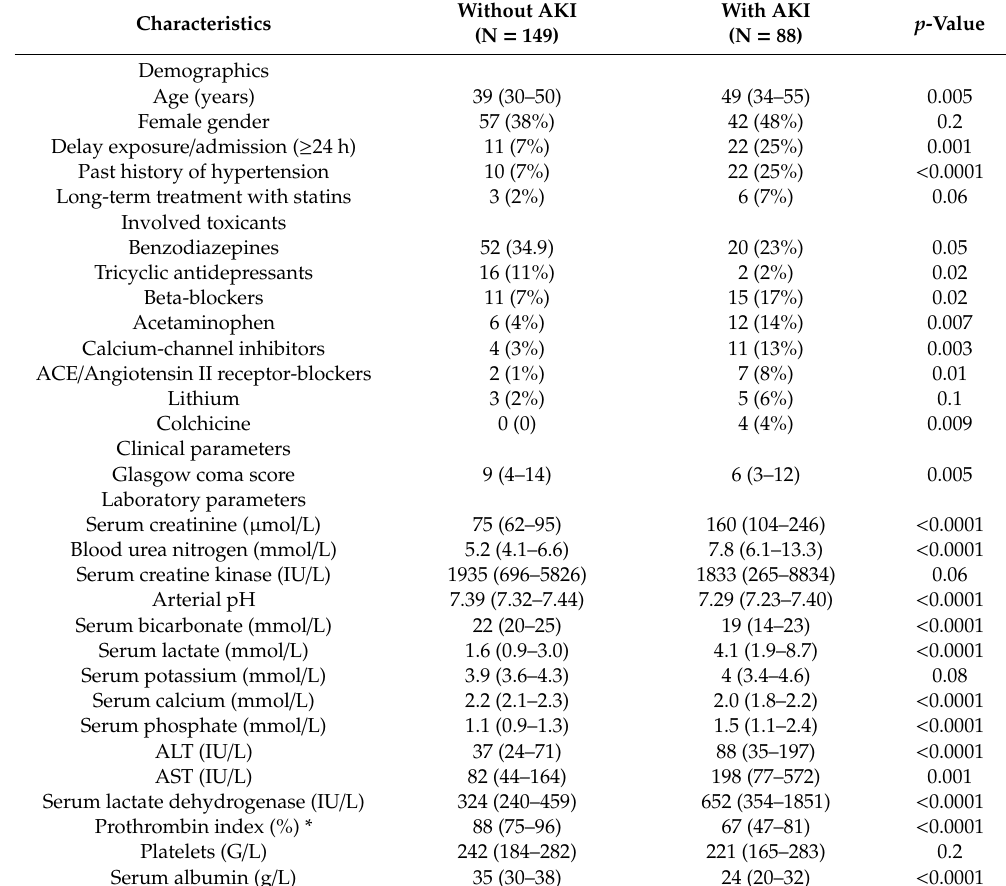
Table 4. Clinical and laboratory parameters in the poisoned patients who developed rhabdomyolysis according to the onset of acute kidney injury (AKI).